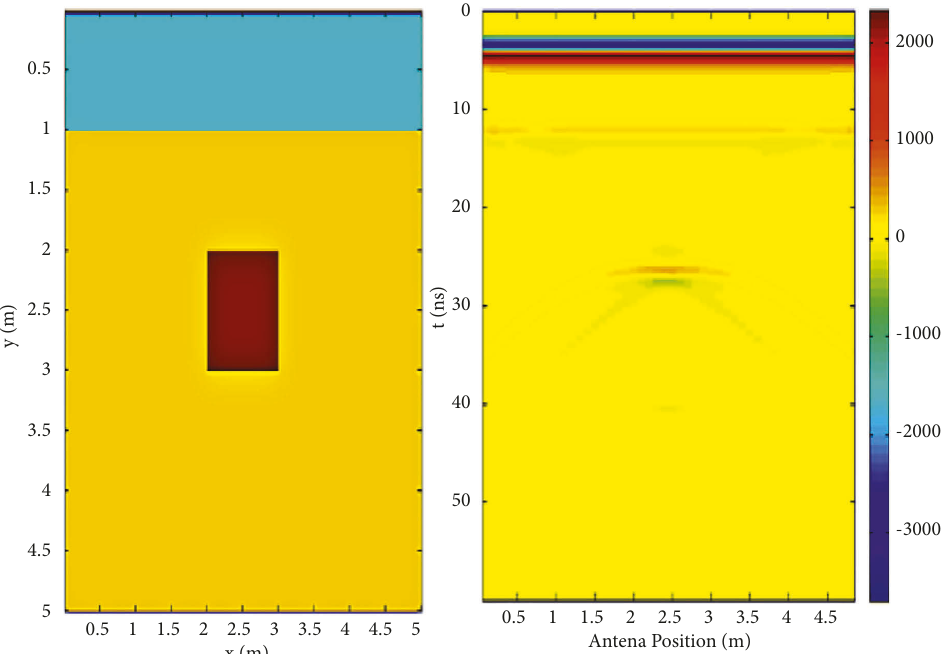
Figure 1: Massive oil and gas pollution model and forward modeling results, left x(m), right antenna position (m).